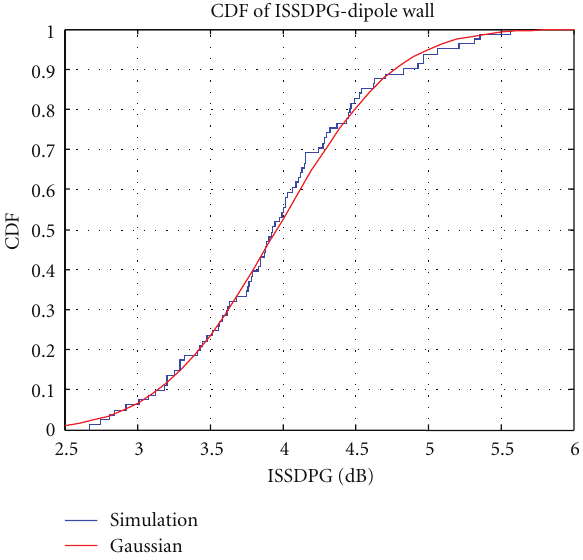
Figure 17: ISSDPG distribution for the dipole-wall scenario.